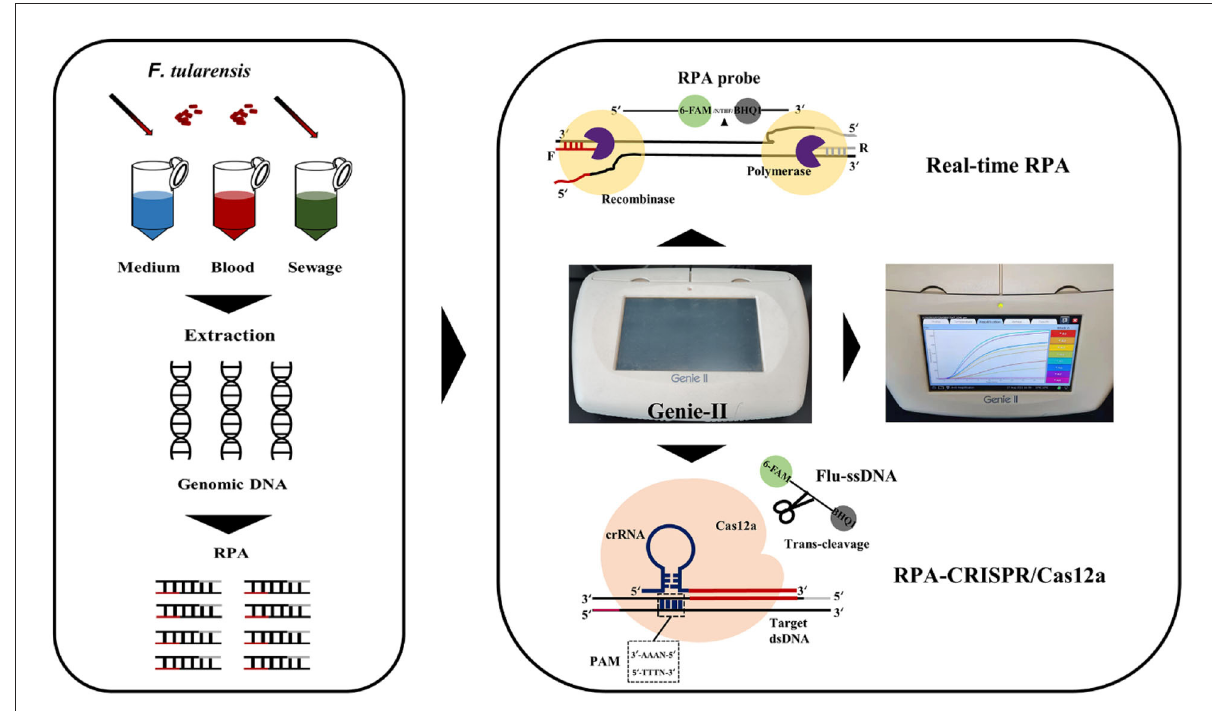
FIGURE1 Schema of assay process for the detection of F. tularensis with RT-RPA and RPA-CRISPR/Cas12a assays.